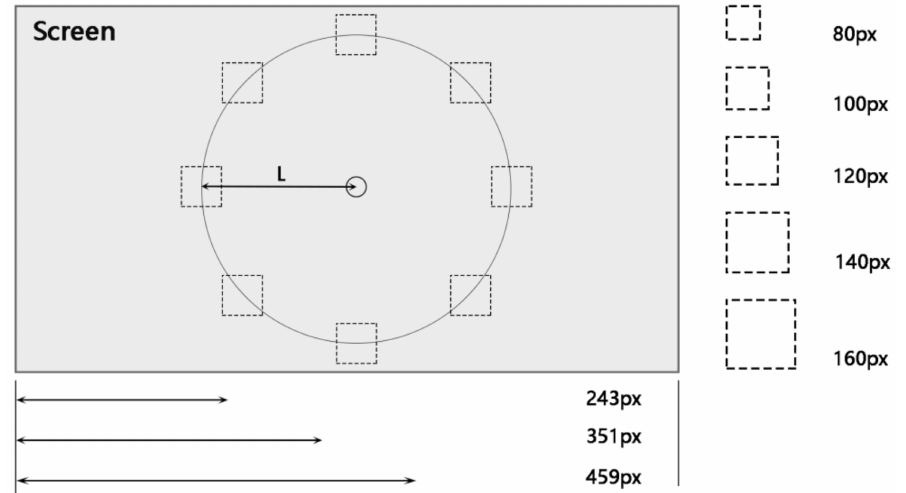
Figure 4. Diagram of experimental interface distribution, distance factor and size